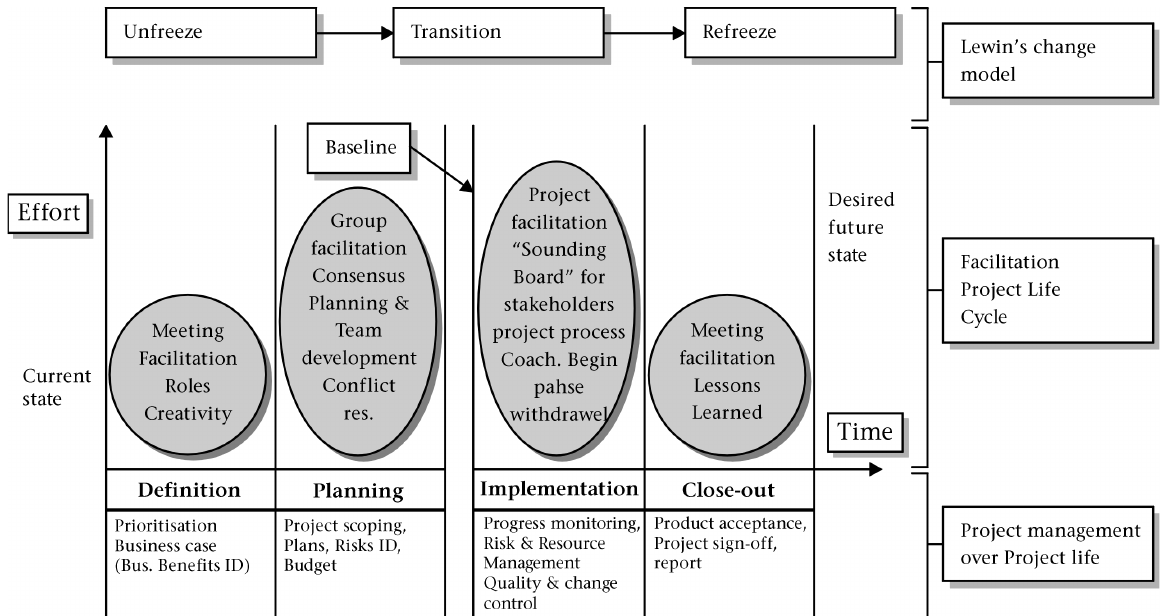
Figure 6: Facilitative project management model version 2: Integrating facilitation skills with project management phases to combine systematic and interactive aspects of